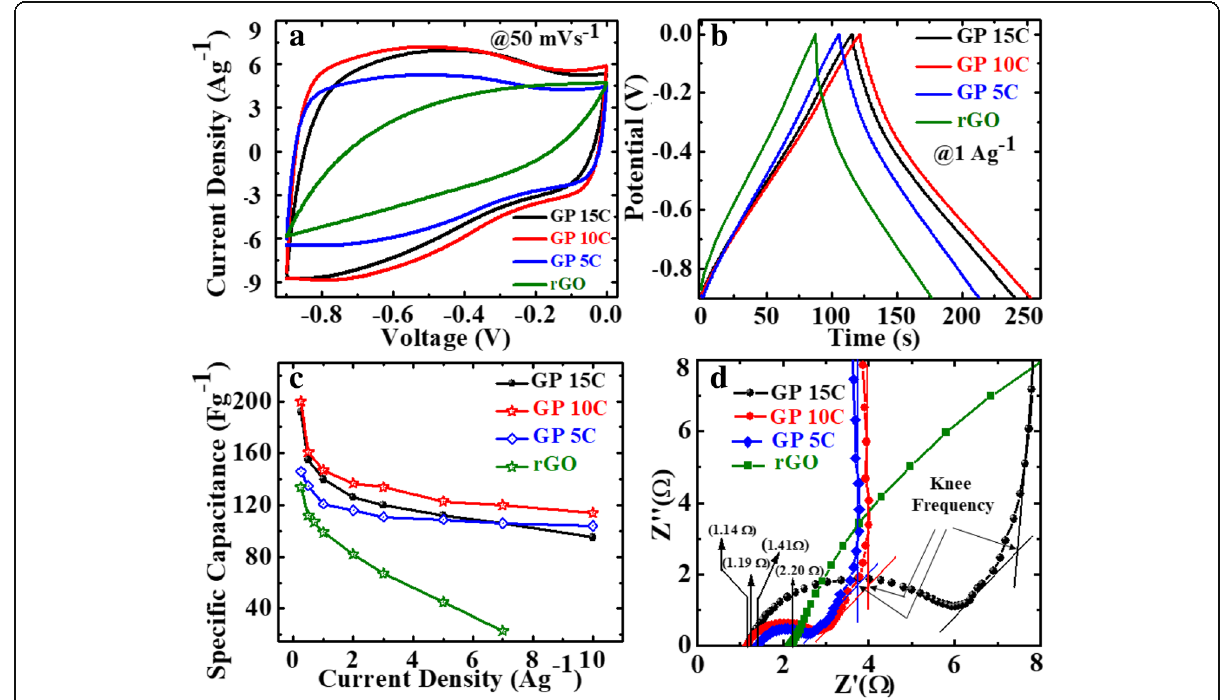
Fig. 8 Electrochemical performance of rGO, GP5C, GP10C, and GP15C electrodes in 2 M KOH electrolyte, a CV curves at the scan rate of 50 mVs − 1 , b GCD curves at the current density 1 Ag − 1 , c CV as determined from GCD curves, and d Nyquist plots comparison of all the